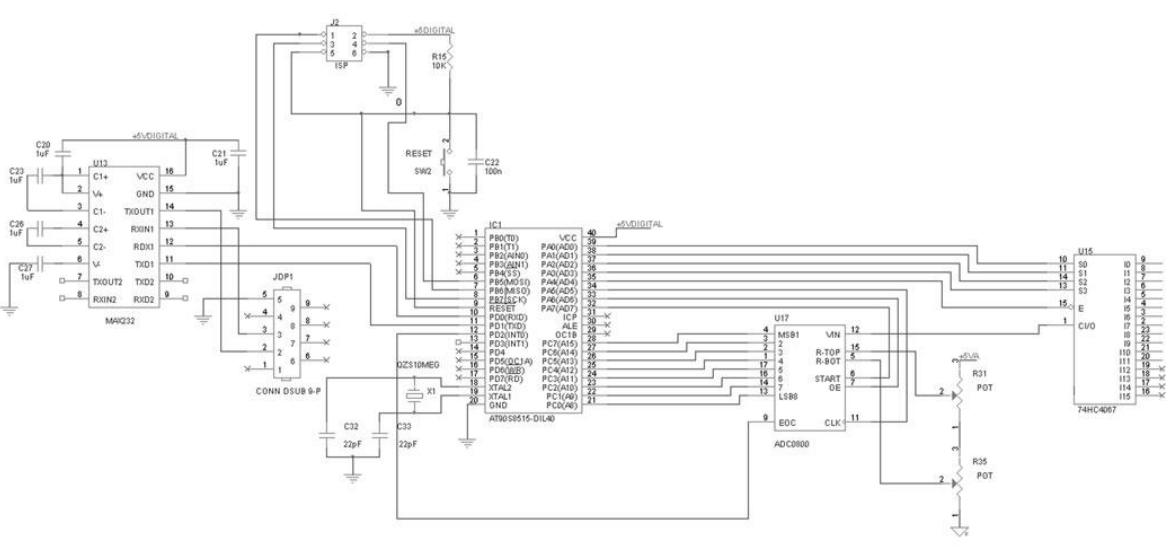
FIGURE 6. Analog to digital conversion circuit